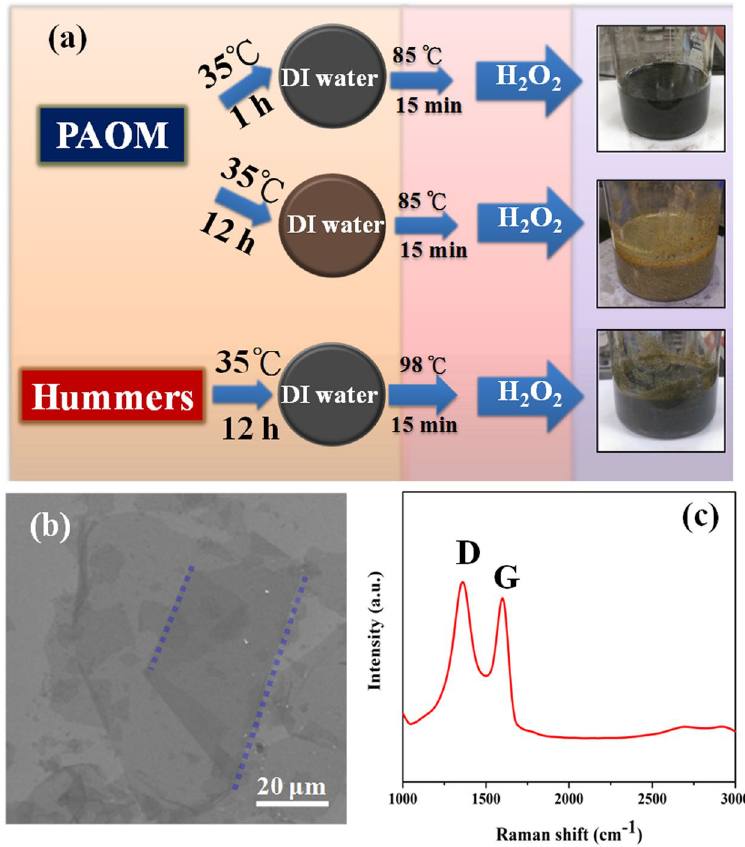
Figure 5. ( a ) The schematic procedure for oxidation of large size graphite flakes with varied reaction time of the 35 °C step. The SEM ( b ) and Raman ( c ) results of the GO products obtained by 12-h PAOM in ( a ). The blue dashed lines in ( b ) are folding lines of the individual GO